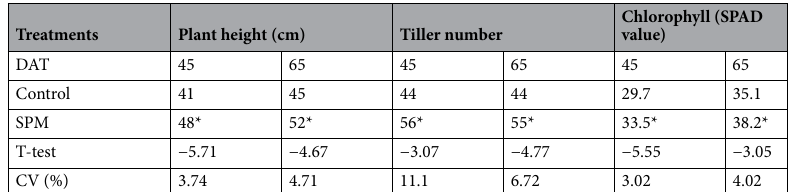
Table 3. Effect of spermine on plant height, tiller number and chlorophyll content in KADA at different days after sowing. T-test was performed at P ≤ 0.05. *: Significant at P ≤ 0.05. DAT: Days after transplanting, SPM: spermine, KADA: Kemubu Agricultural Development Authority and CV: Coefficient of variation.